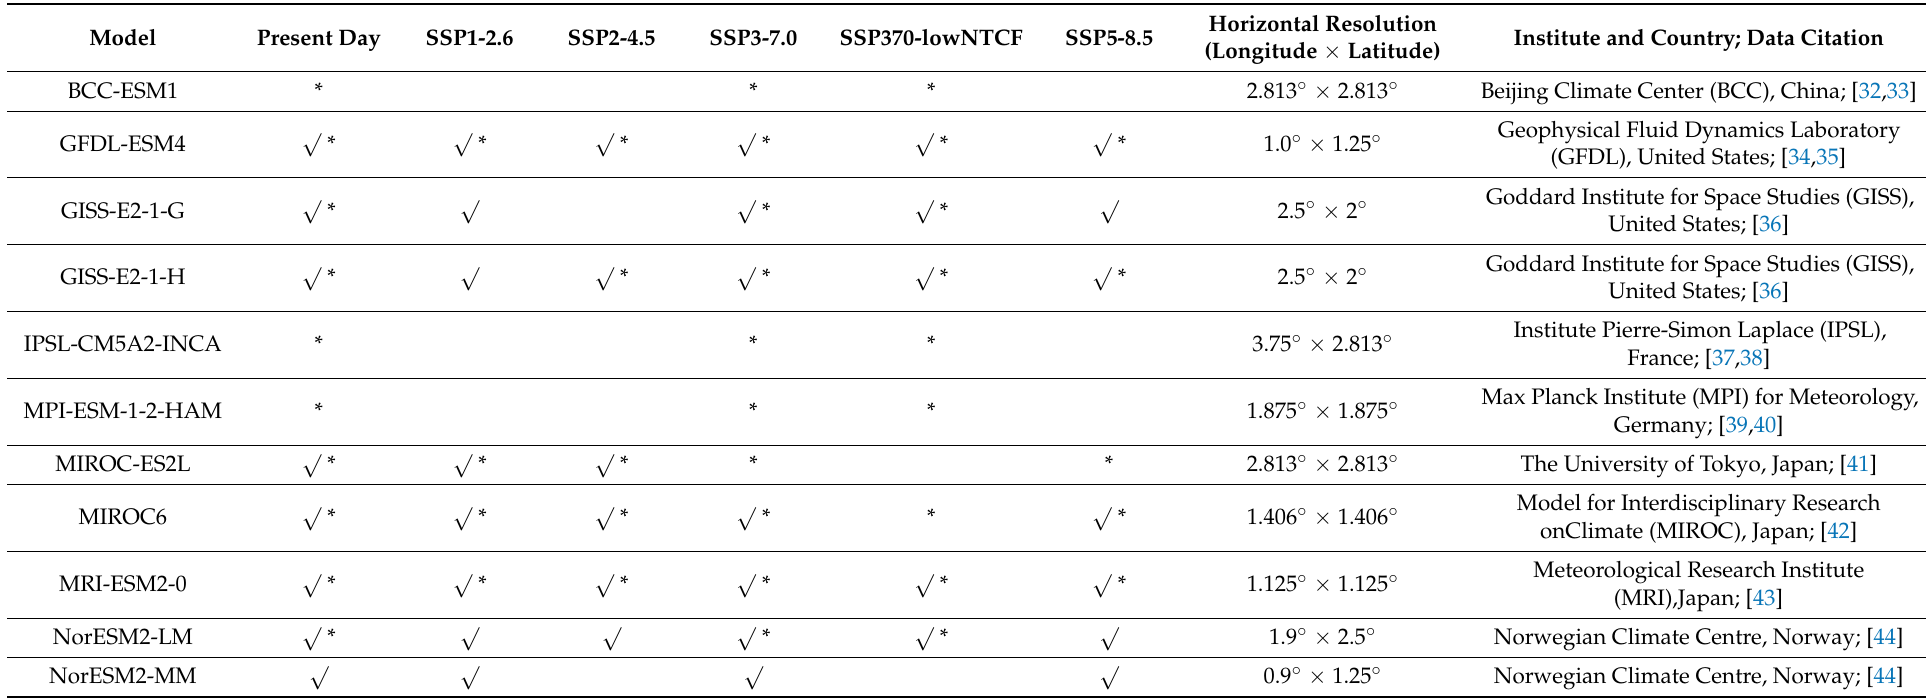
Table 1. List of CMIP6 models used in this